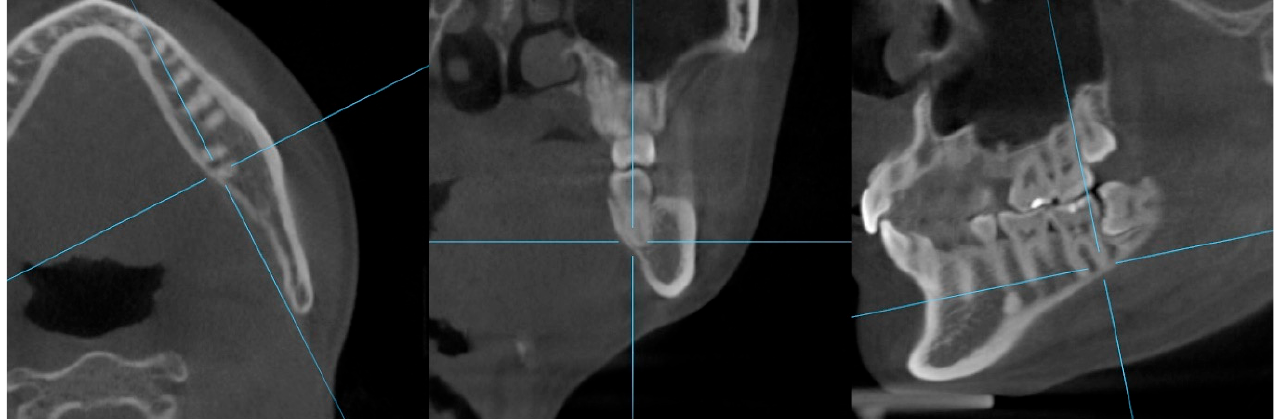
Figure 4. Confirmation of contact between mandibular molar roots and lingual cortical bone with multiplanar reconstruction images. multiplanar reconstruction